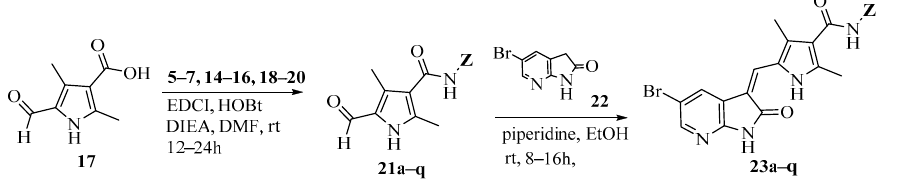
Scheme 3. Synthesis of target compounds 23a – q .